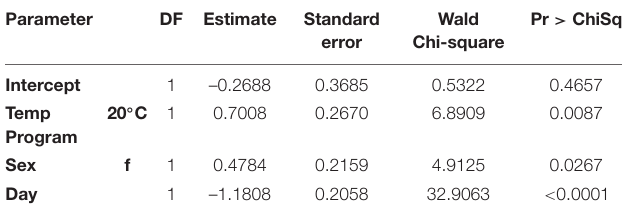
TABLE 2 | Analysis of maximum likelihood estimates for blackberry detectability over time.